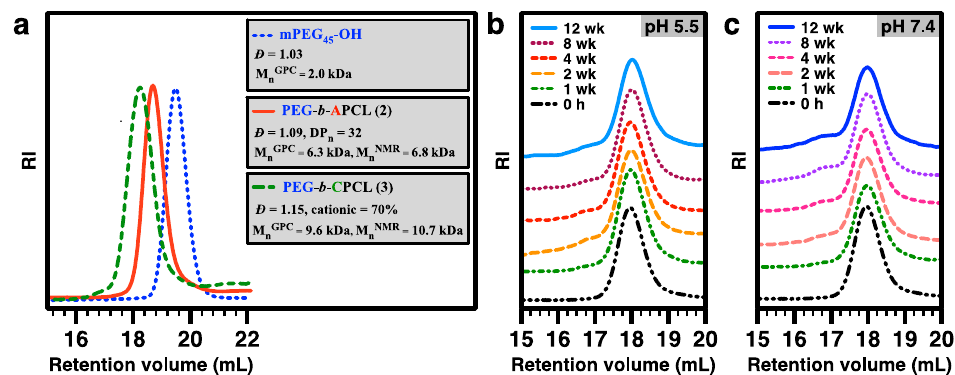
Figure 7. ( a ) GPC characterization of mPEG 45 -OH as the ROP macroinitiator, PEG- b -APCL ( 2 ), and PEG- b -CPCL-70 ( 3 ) with DMF as eluent. ( b ) GPC curves of 3 after incubation at pH 5.5 PBS buffer at 37 °C. ( c ) GPC curves of 3 after incubation at pH 7.4 PBS buffer at 37 °C.